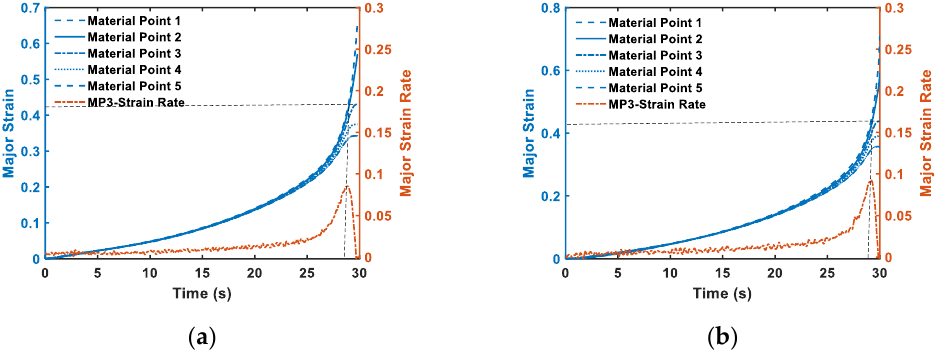
Figure 12. Major strain and strain rate evolution for two independent tests on a 25 mm wide specimen: ( a ) the first test; ( b ) the second test.